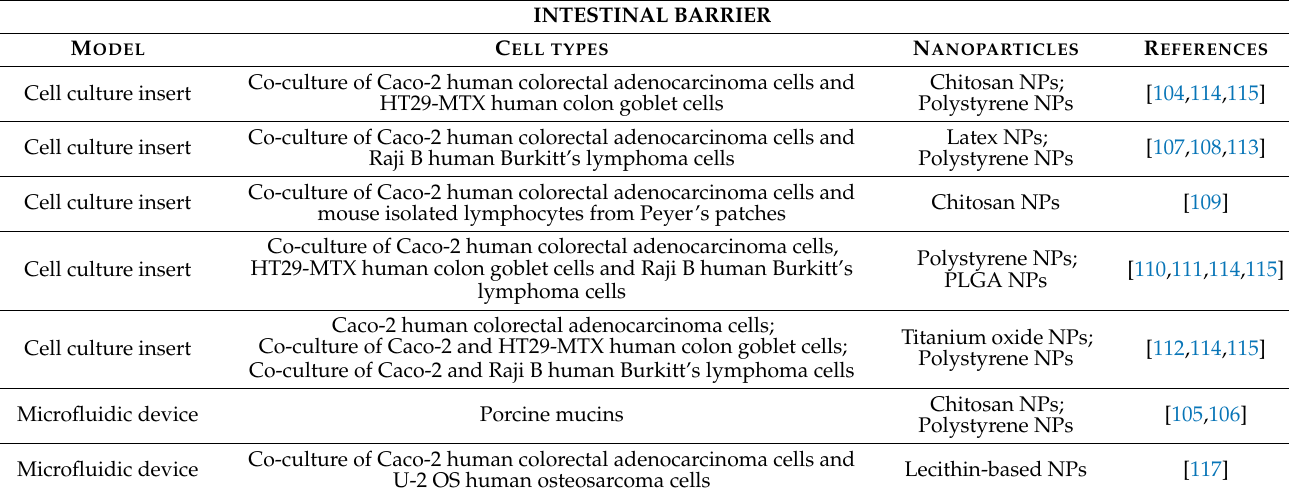
Table 5. Summary of in vitro intestinal barrier models used for nanomedical